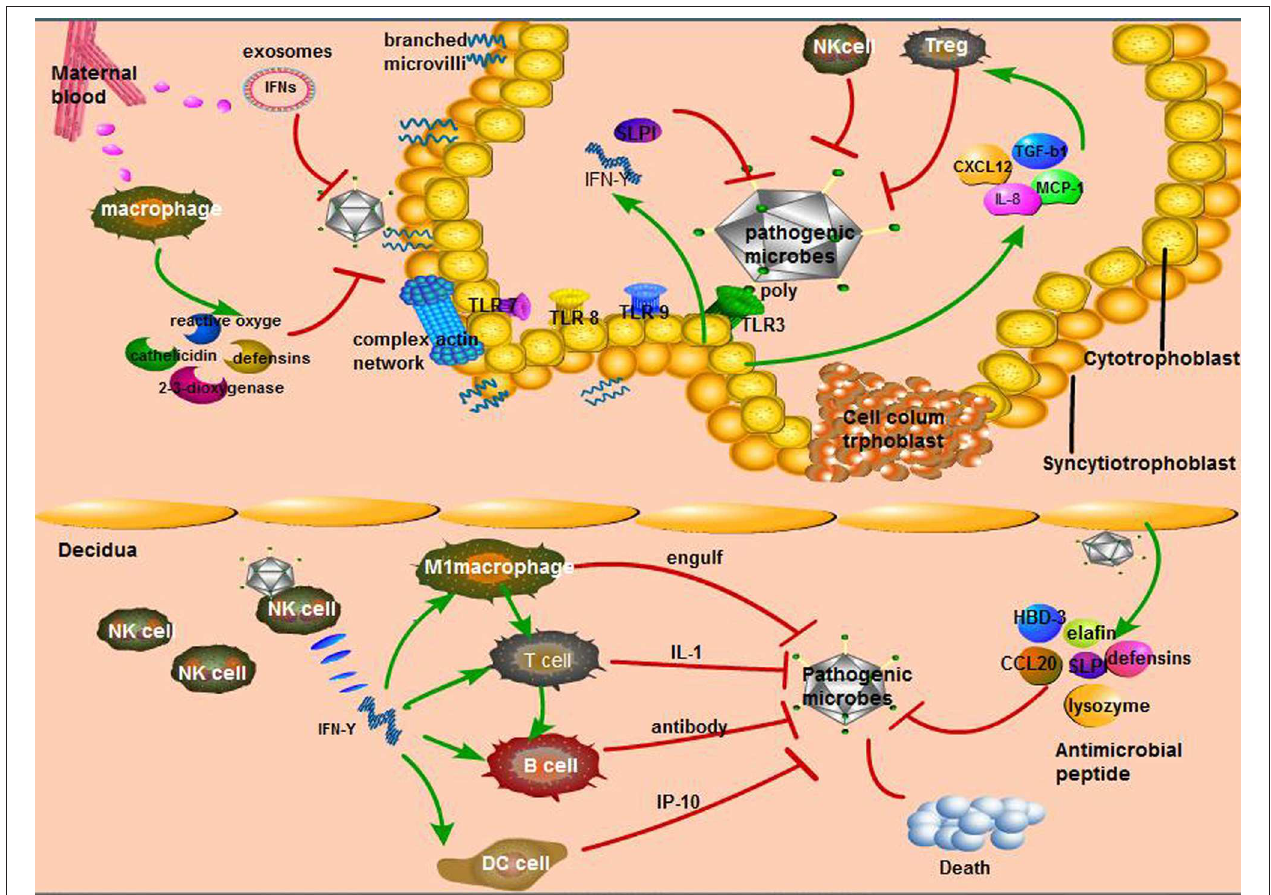
FIGURE 2 | Unique way of maternal-fetal interface resistance to microorganisms. (1) The main immune response in the maternal decidua: interferon (IFN)- γ secreted by natural killer (NK) cells, the most affluent cells in maternal decidua, recruits other immune cells to perform active function. Second, various antimicrobial peptides secreted by decidua cells can resist pathogenic microorganisms; (2) The cytotrophoblast relies on its diverse Toll-like receptors (TLRs) to recognize bacteria, fungi, and so on, then causes the secretion of diversity anti-inflammatory factors that activate specific immune cells; (3) The defensive role of syncytiotrophoblast is mainly from the hardness of its cells consisting of branching microvilli and complex actin network as well as maternal macrophages.